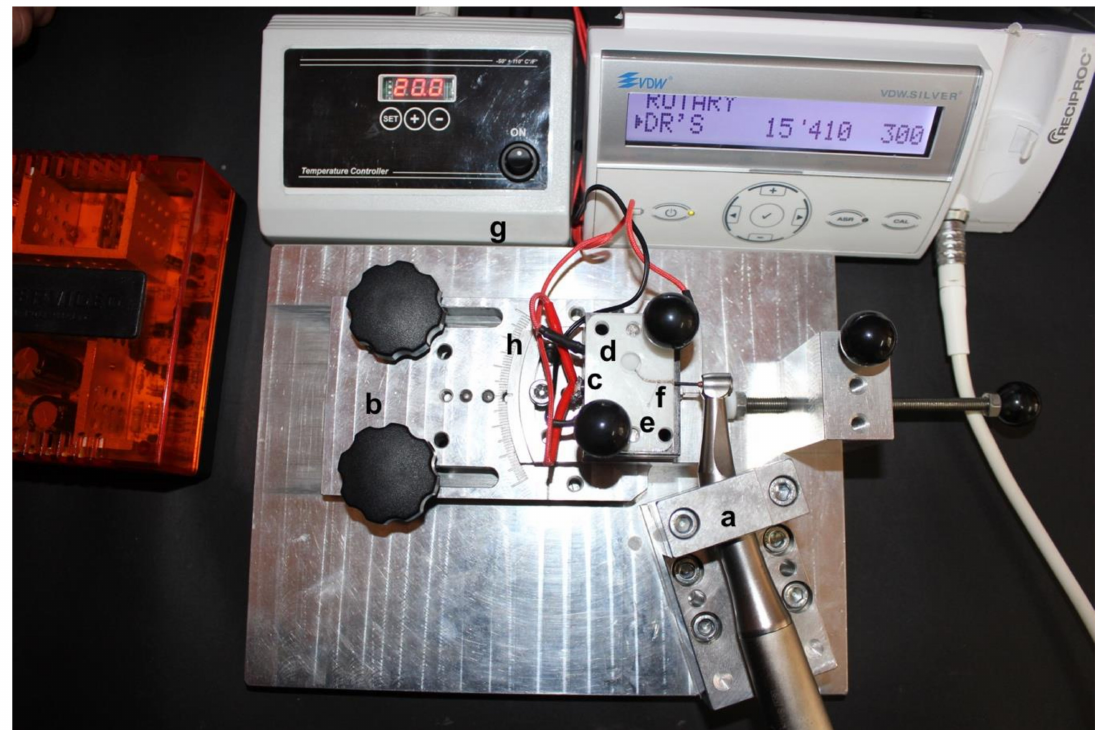
Figure 1. The custom-made apparatus for cyclic fatigue tests with an OneCurve (OC) file and a preset temperature of 20 ◦ C. ( a ) The fixed block in which the electric handpiece is inserted and ( b ) the mobile support on rails to allow the insertion / withdrawal of the file; ( c ) the ceramic canal with a 60 ◦ angle and a 5-mm radius covered by the superimposition of two Plexiglas slides; ( d ) the hole made on the cover near the corresponding canal apex to permit the outflow of the solution during the test through an aspiration system; ( e ) the insertion point of the irrigant tip and ( f ) the channel built inside the cover to permit the irrigant flow during the test; ( g ) the thermostat which allowed the temperature adjustment through to a thermocouple ( h ) applied to the artificial